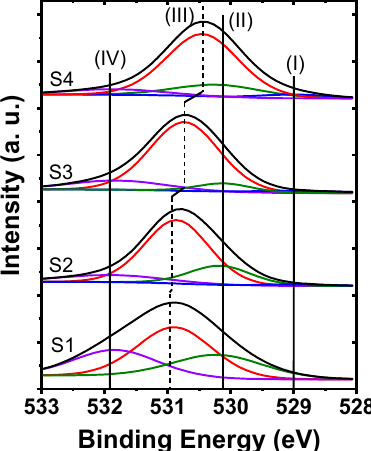
Figure 1. O 1s XPS spectra of HfO 2 film and HfO 2 /La 2 O 3 gate stacks deposited on Ge substrates.